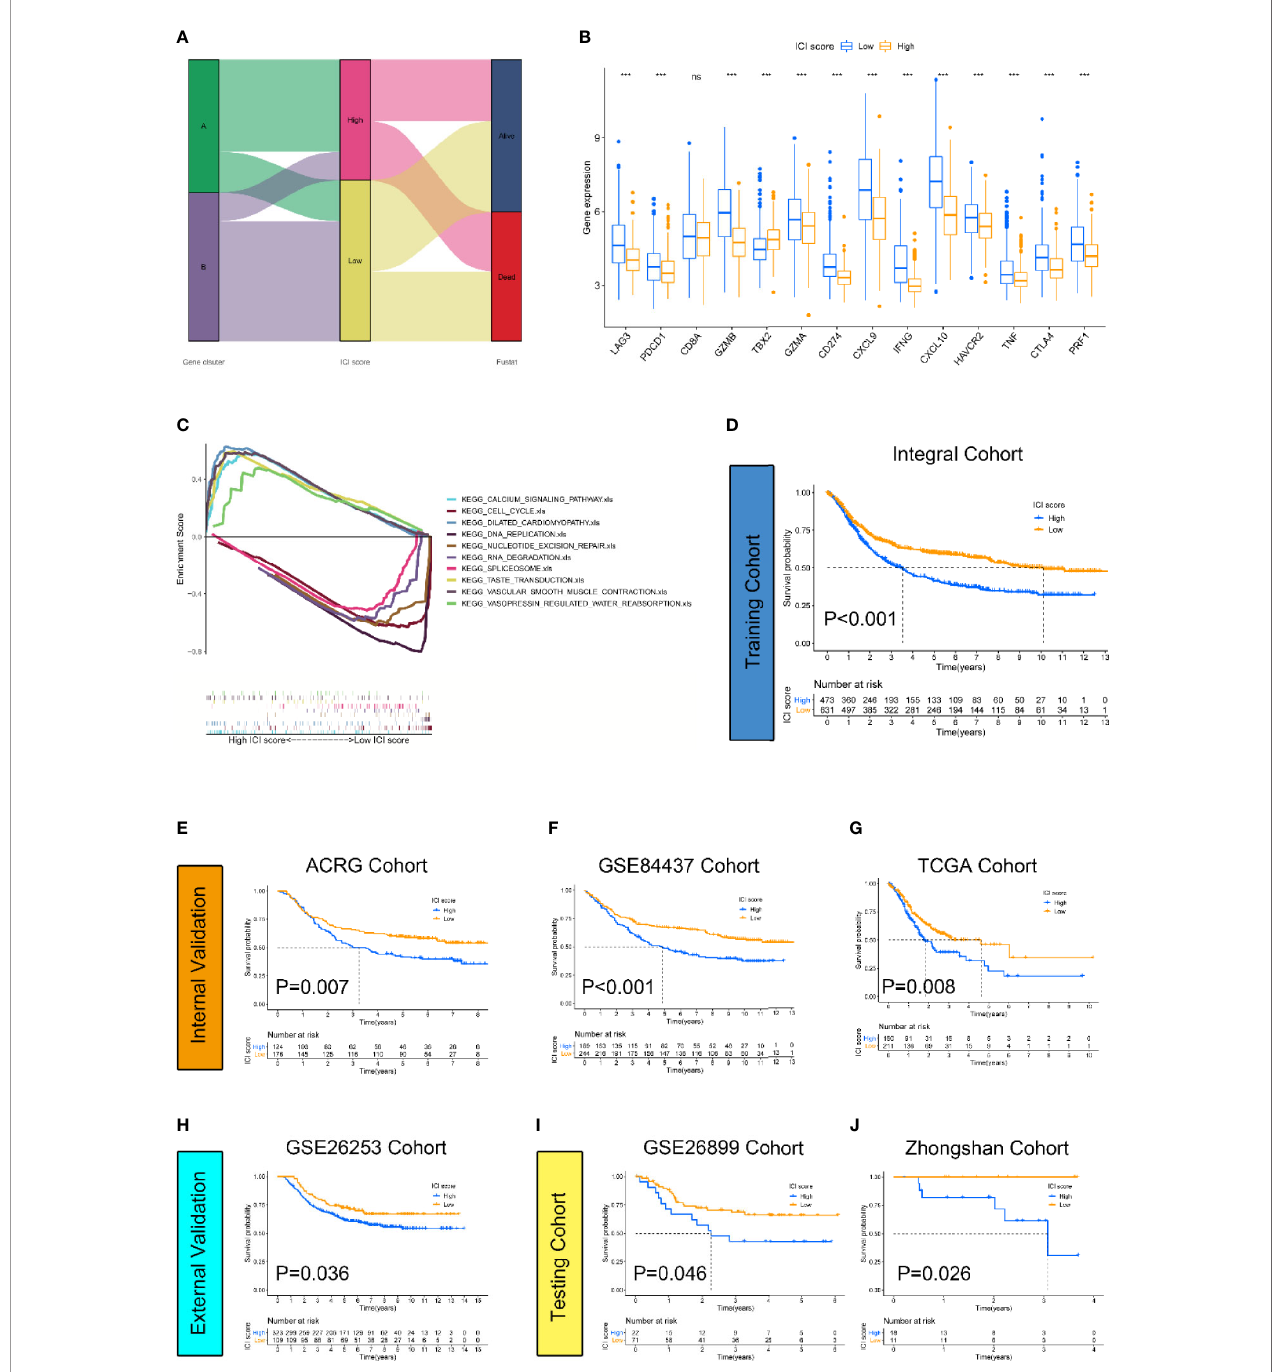
FIGURE 3 | Construction and validation of the ICI score classi fi cation system. (A) Alluvial diagram revealed the correlations between different ICI clusters, ICI scores, and survival outcomes. (B) Expression level of immune-checkpoint-relevant genes were signi fi cantly higher in low ICI score group. (Kruskal-Wallis test. ***p < 0.001; ns, not signi fi cantly different). (C) GSEA KEGG enrichment analysis. CALCIUM_SIGNALING_PATHWAY, CELL_CYCLE, DILATED_CARDIOMYOPATHYECM, DNA_REPLICATION and NUCLEOTIDE_EXCISION_REPAIR pathways are enriched in high ICI score cohort while RNA_DEGRADATION, SPLICEOSOME, TASTE_TRANSDUCTION, VASCULAR_SMOOTH_MUSCLE_CONTRACTION and VASOPRESSIN_REGULATED_WATER_REABSORPTION pathways are enriched in low ICI score cohort. (D – J) The log rank test shown by Kaplan-Meier curves indicated a better overall survival for low ICI score groups in all datasets, including training cohort {(Integral Cohort, p = 0.007) (D) , internal validation cohort (ACRG Cohort, p < 0.001) (E) , (GSE84437 Cohort, p < 0.001) (F) , (TCGA Cohort, p =0.008) (G) , external validation cohort (GSE26253 Cohort, p = 0.036) (H) and testing cohort (GSE26899 Cohort, p = 0.046) (I) , (Zhongshan Cohort, p =0.026) (J)